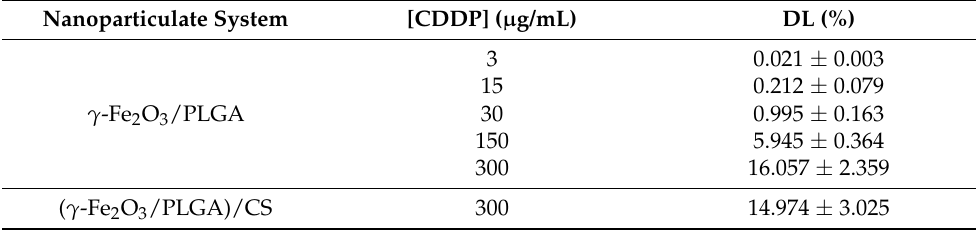
Table 3. Loading of CDDP (DL, %) to the γ -Fe 2 O 3 /PLGA, and ( γ -Fe 2 O 3 /PLGA)/CS particles.